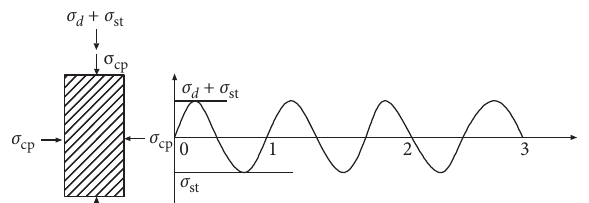
Figure 12: Stress state acting on the specimen and loading waveform [52].